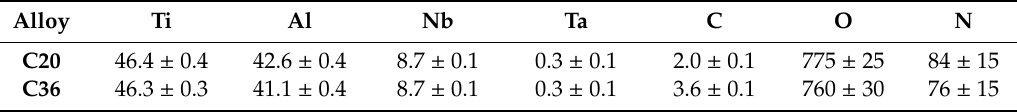
Table 1. Chemical composition of studied alloys (at.%) and content of O and N (wt.ppm).